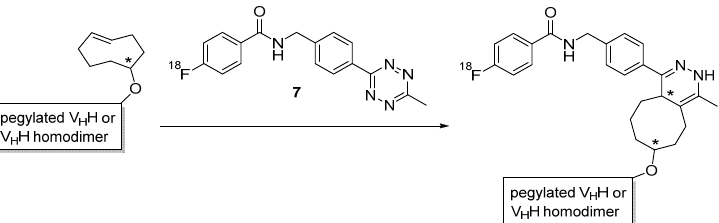
Figure 9. 18 F-labeling of polyethylene glycol-functionalized or homodimeric nanobodies with 7 through IEDDA cycloaddition [42].